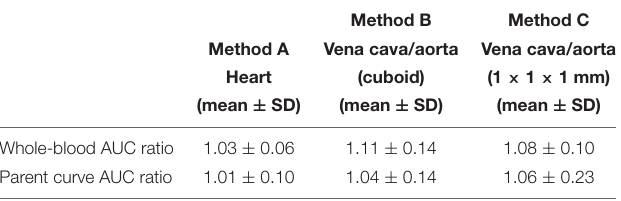
TABLE 1 | Mean AUC ratios (IDIF/AIF) for each VOI related IDIF in both whole-blood and parent curves.